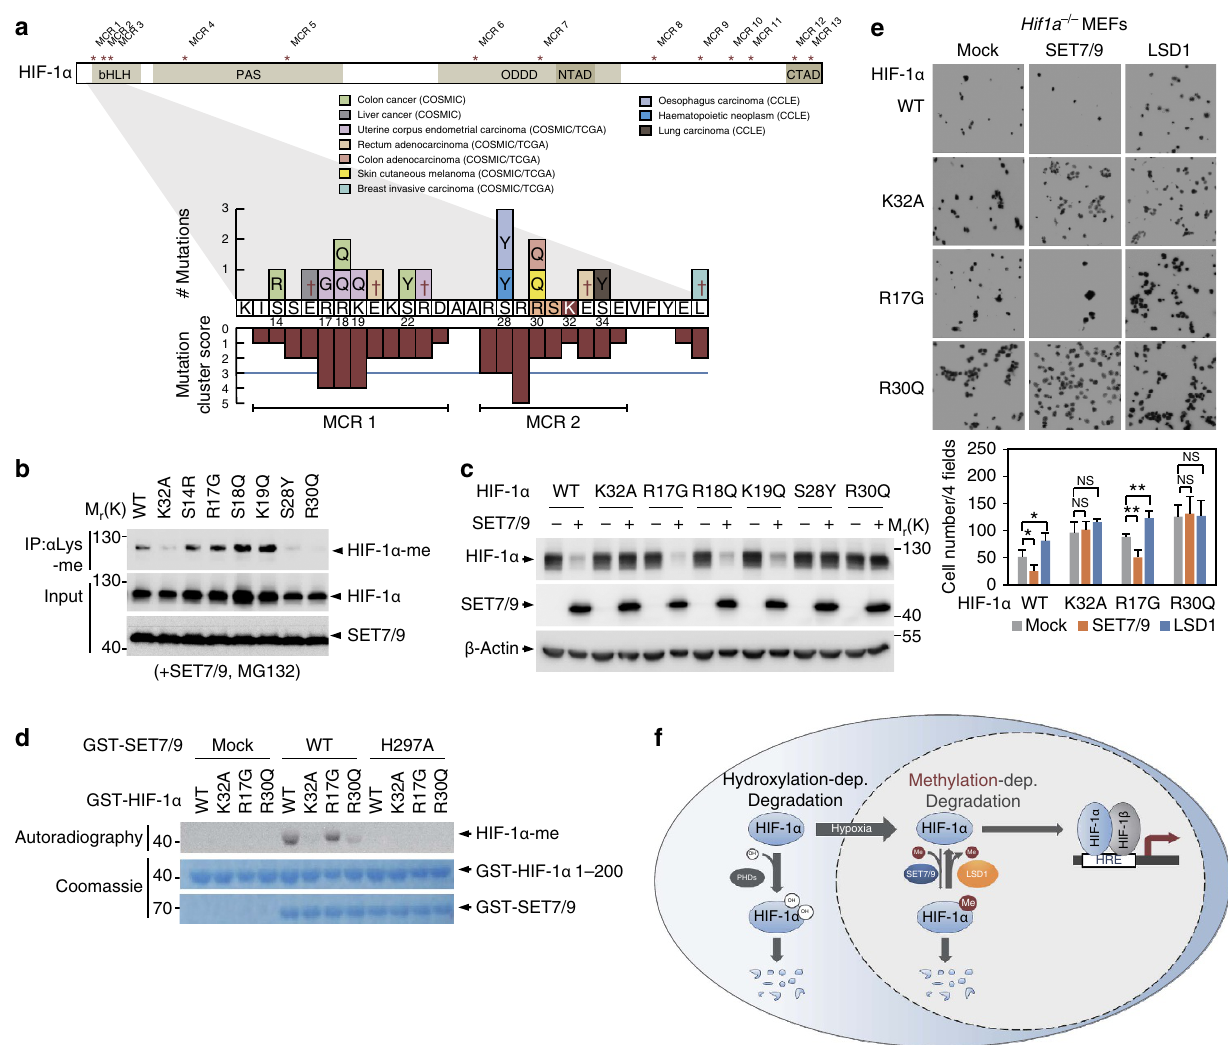
Figure 7 | Biological significance of HIF-1 a methylation in human cancers. ( a ) Schematics indicating known HIF-1 a mutations in various cancer patients and cancer cell lines. For each amino acid, the mutation cluster score was calculated as the sum of the numbers of mutations of the amino acid and two neighbouring amino acids based on the scan statistics as previously described 68 . Mutation cluster regions (MCRs) were then determined as the regions within which the maximum mutation cluster score Z 3 (random permutation test, P -value o 0.05) and the number of amino acids Z 5 and were denoted by asterisks in the entire protein structure of HIF-1 a . MCRs 1 and 2 close to K32 were shown in detail with mutation cluster scores within the regions. Reference sequences for 12 to 40th amino acid residues of HIF-1 a are denoted in the boxes on x axis. Sequence changes resulted from the mutations are shown in the boxes above the reference sequences and synonymous mutations are denoted by the cross ( w ) symbols. Numbers under the boxes indicate the presence of non-synonymous mutations in the corresponding residues. P -value for each mutation cluster score was computed using the null hypothesis distribution of the mutation score estimated by randomly permuting the mutations within HIF-1 a . ( b , c ) SET7/9-dependent methylation of HIF-1 a ( b ) and protein stability of HIF-1 a ( c ) were determined in HeLa cells expressing the indicated HIF-1 a MTs. ( d ) In vitro methylation assay of HIF-1 a WT, K32A and MTs from cancer patients was performed by SET7/9 WT or enzymatic MT (H297A). ( e ) Photomicrographs of Transwell cell migration assays of Hif1a (cid:2) / (cid:2) MEFs reconstituted with the indicated proteins under normoxic conditions for 12h. Representative images are shown for each group. Bar graph shows the mean number of cells per filter ± s.d. ( n ¼ 4 for each group, t -test, * P o 0.05, ** P o 0.01). ( f ) In the cytoplasm, HIF-1 a protein stability is regulated by PHD-dependent hydroxylation. The hydroxylated HIF-1 a binds to VHL for CUL2-dependent degradation by 26S proteasomes under normoxic conditions to maintain low HIF-1 a protein levels. In contrast, SET7/9-dependent methylation and LSD1-dependent demethylation of HIF-1 a regulate protein stability primarily in the nucleus in a hydroxylation- and VHL-independent manner during normoxia and long-term hypoxia. involvement of SET7/9 and LSD1 in regulating retinal and lysine sites of HIF-1 a depending on different upstream signals, tumour angiogenesis. hypoxia-dependent HIF-1 a methylation and demethylation at Set7/9 KO mice are normal and largely indistinguishable from K32 site is conducted by SET7/9 and LSD1, respectively. The their WT littermates in both viability and fertility 53 ; thus, the finding that HIF-1 a methylation affects protein stability led us to roles of SET7/9 in cancer have not been explored in mouse generate HIF-1 a methylation-deficient mice to explore the models. However, several reports have suggested potential roles biological function of HIF-1 a methylation in vivo . Hif1a KA/KA mice exhibited enhanced retinal angiogenesis and tumour for SET7/9 in cancer. The SET7/9-mediated methylation of p53 vascularization via HIF-1 a stabilization, indicating the potential has been shown to facilitate its acetylation, which subsequently NATURE COMMUNICATIONS|7:10347|DOI: